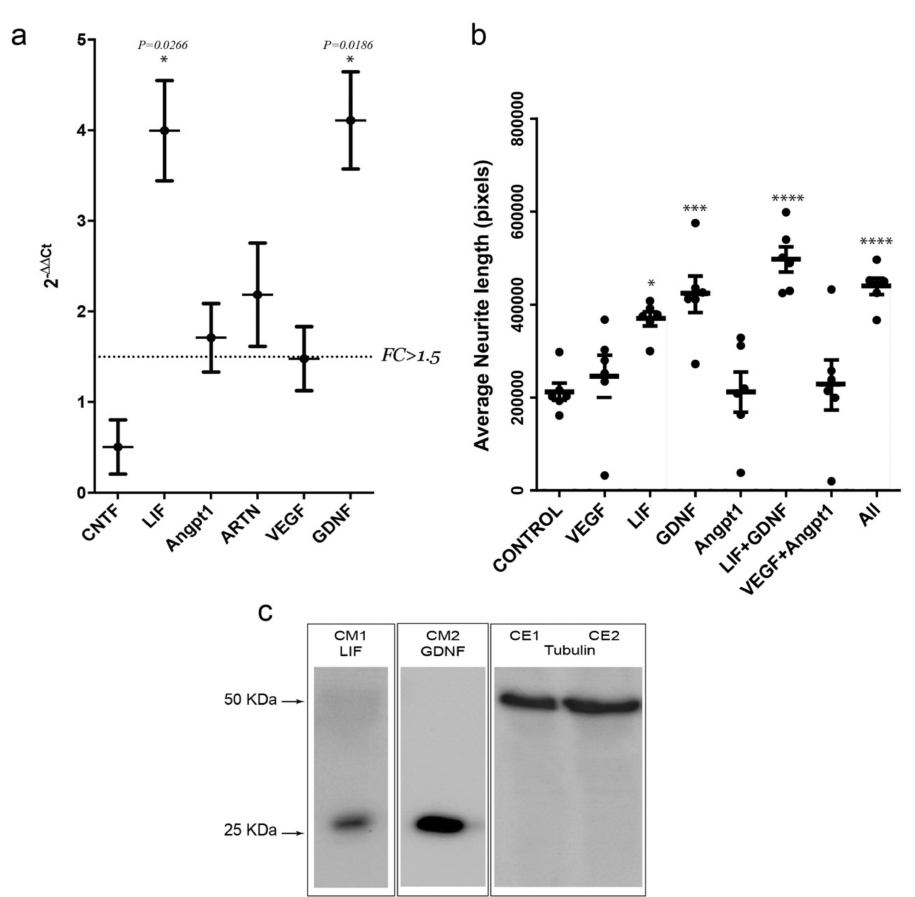
Figure 6. ( a ) Graph illustrating the RT-qPCR data of the selected mRNAs after stimulation of C2C12-ChR2 positive myotubes in the MFDs. The dashed line in (a) marks the threshold of the fold change (FC) used in the statistics (FC > 1.5). ( b ) Graph illustrating the average neurite length of spinal cord explants ( y -axis) in each treatment condition ( x -axis). Each dot represents an independent biological replicate. Plotted data correspond to mean ± S.D. Asterisk indicates statistical significance vs. control (* p < 0.05; *** p < 0.001 and **** p < 0.0001). ( c ) Western blot illustrating the presence of LIF and GDNF in the culture media (CM) of two di ff erent devices after optical stimulation of the C2C12-ChR2 myotubes. The presence of tubulin in the cell extracts (CE) of the two C2C12-ChR2 positive stimulated cells is also